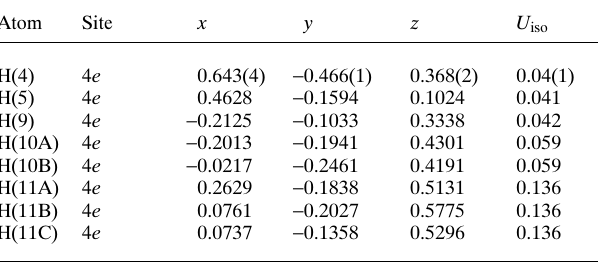
Table 2. Atomic coordinates and displacement parameters (in Å 2 )